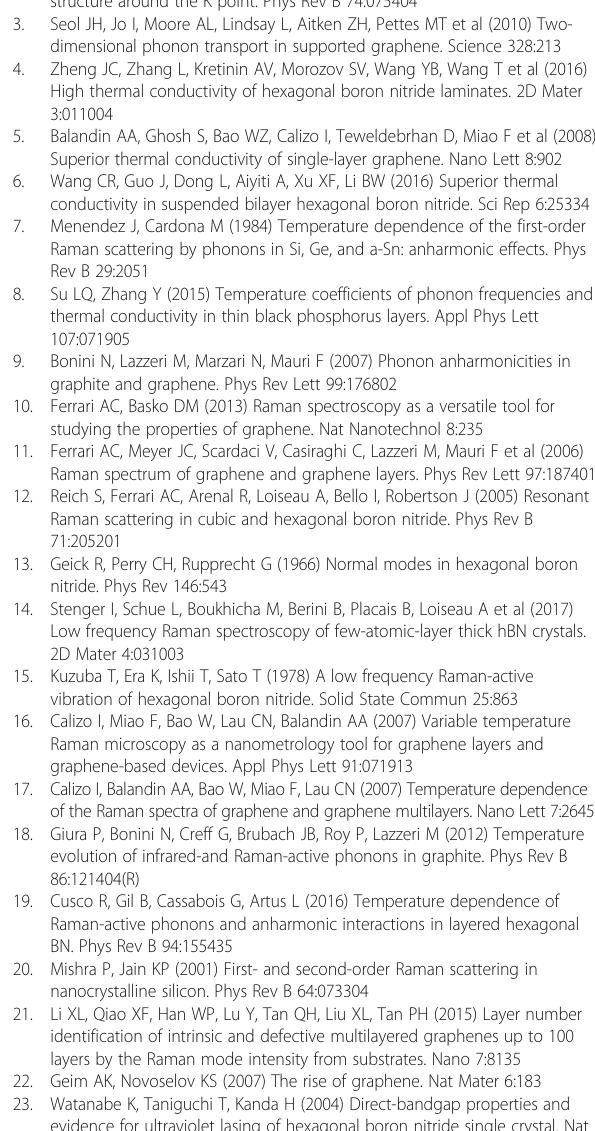
Table 2 Temperature dependence of FWHM of E 2ghigh peak and G peak are fitted by Γ ph = Γ ph0 + ct, and the constants of Γ ph0 and c are given in the